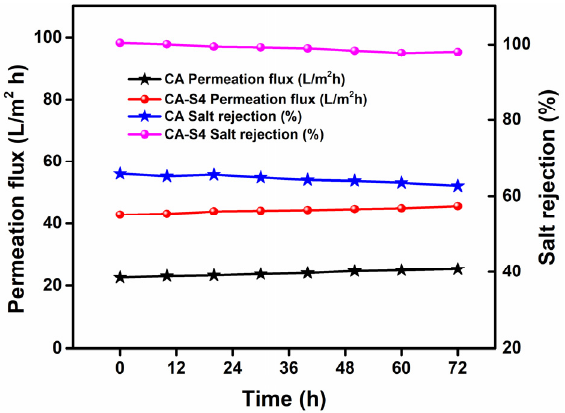
Figure 5. Short term stability of CA and CA-S4 NF-TFC membranes using NaCl 3.28 wt % concentration at a working pressure of 55.2 bar.